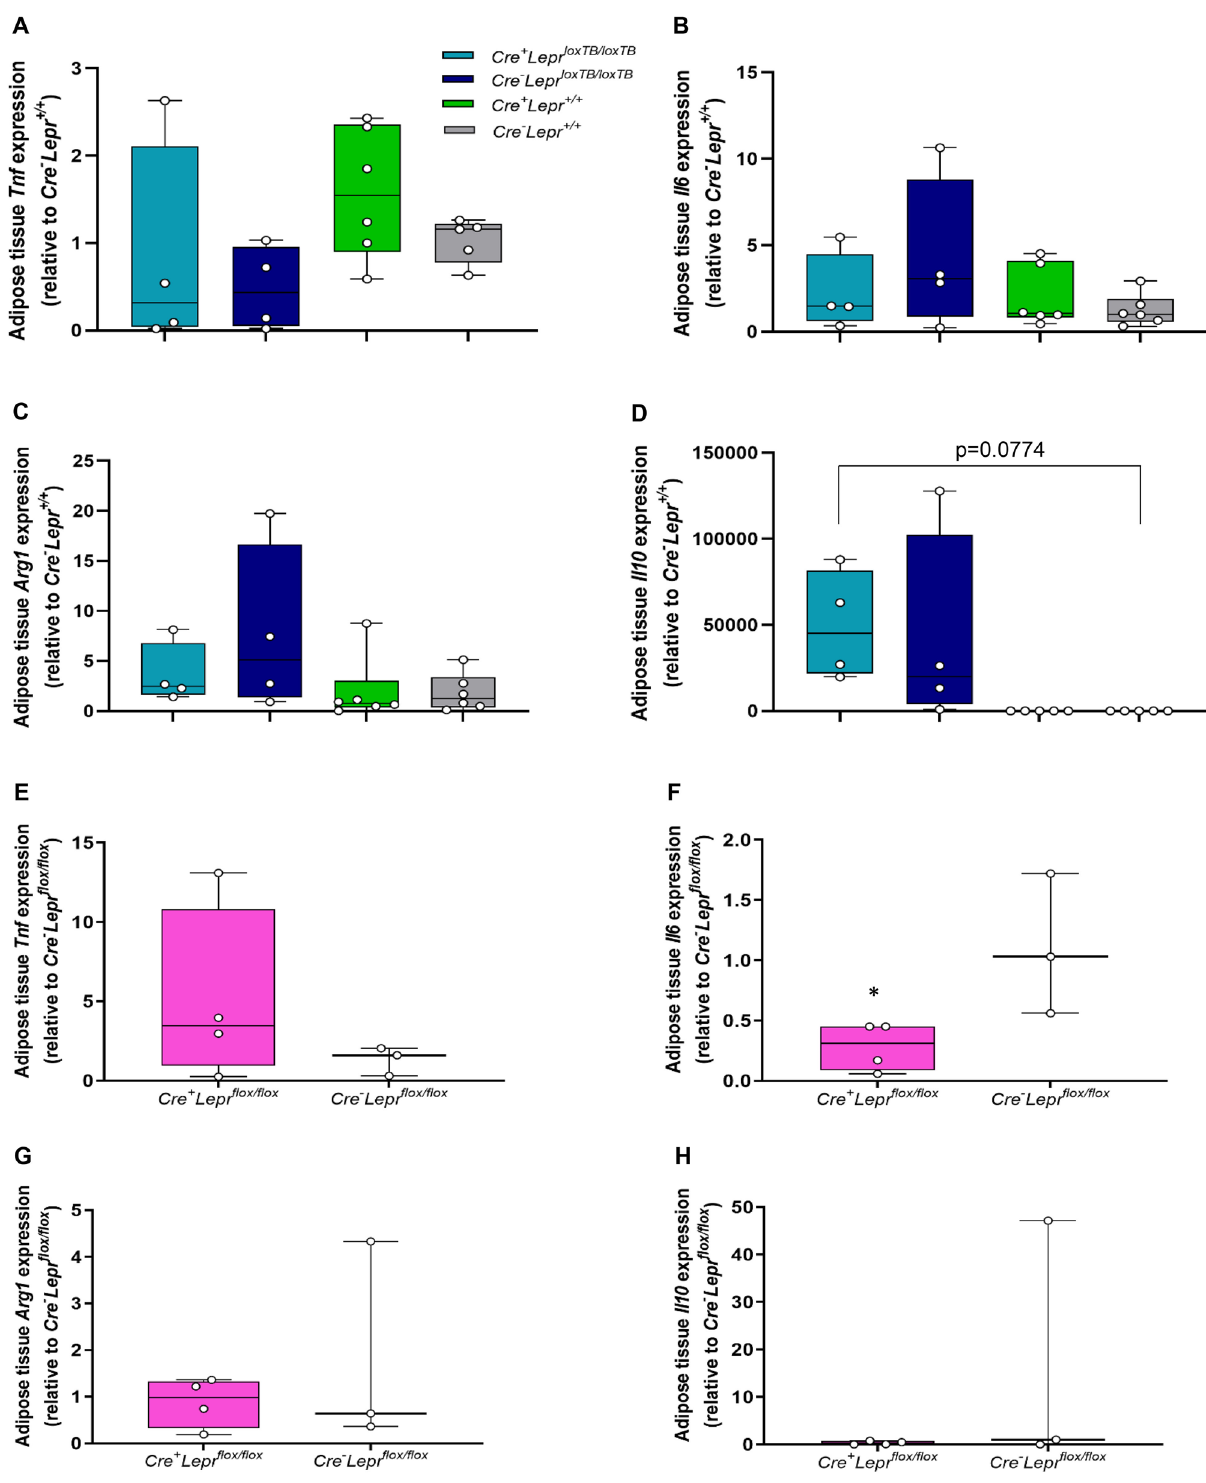
Figure 11. Adipose tissue pro- and anti-inflammatory cytokine expression assessed by RT-qPCR in males from the Lepr reconstitution and Lepr knockdown studies. In ( A ), n = 4 for Cre + Lepr loxTB/loxTB , n = 4 for Cre − Lepr loxTB/loxTB , n = 6 for Cre + Lepr + / + , and n = 5 for Cre − Lepr + / + . In ( B ) and ( C ), n = 4 for Cre + Lepr loxTB/loxTB , n = 4 for Cre − Lepr loxTB/loxTB , n = 6 for Cre + Lepr + / + , and n = 6 for Cre − Lepr + / + . In ( D ), n = 4 for Cre + Lepr loxTB/loxTB , n = 4 for Cre − Lepr loxTB/loxTB , n = 5 for Cre + Lepr + / + , and n = 5 for Cre − Lepr + / + . In E–H, n = 4 for Cre + Lepr flox/flox and n = 3 for Cre − Lepr flox/flox . Performed one-way ANOVA followed by Dunnett’s post-hoc test for Lepr reconstitution study and unpaired t-test for Lepr knockdown study. *p < 0.05, Cre + Lepr flox/flox vs. Cre − Lepr flox/flox